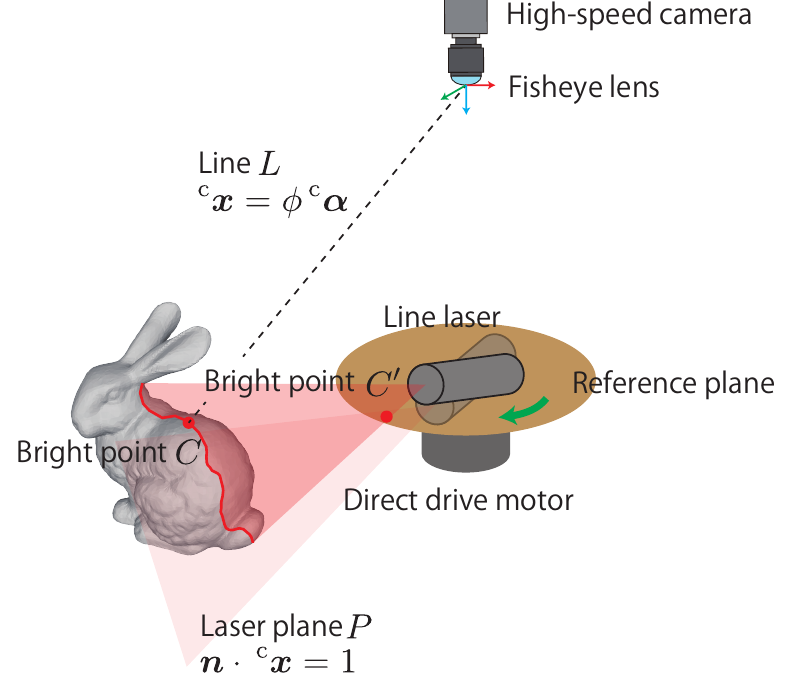
Figure 2. Configuration of